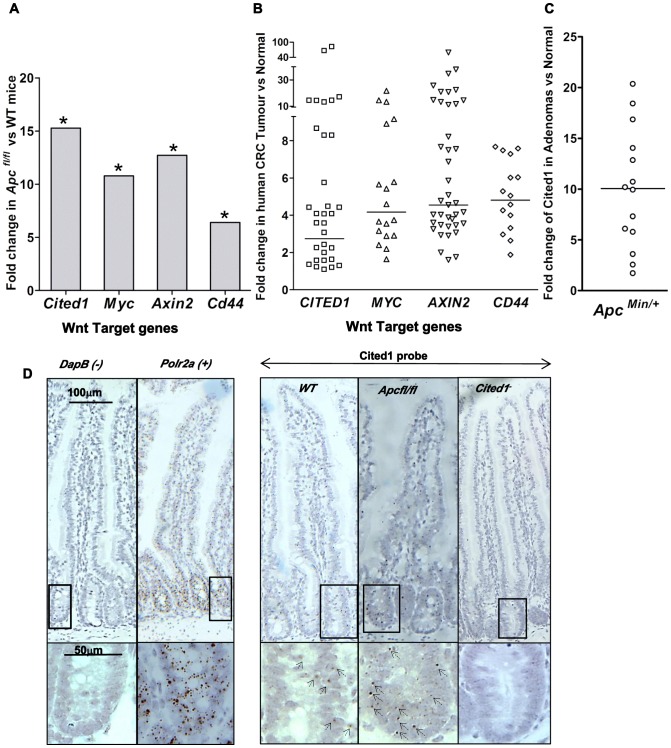

Cited1 over-expression in ApcMin/+ mice, AhCre+Apcfl/fl mice and human colorectal cancer.
A:
 QPCR analysis of Wnt target genes 4 days after conditional deletion of Apc in the small intestinal. * p<0.05, Mann-Whitney U test, n = 3. B: Taqman qPCR analysis of gene expression in human CRC tumour tissue presented as fold change relative to adjacent normal tissue. The horizontal line indicates median fold change. p<0.01, Wilcoxon Signed Rank Test. C: Semi-QPCR analysis of Cited1 expression in ApcMin/+ adenomas. Three ApcMin/+ mice were used and 3–6 tumours were taken from each individual, n = 14. (p<0.01, Mann-Whitney U test). D:
Cited1 in situ hybridization showing the increase in Cited1 expression in the AhCre+Apcfl/fl compare to AhCre+WT mouse. The staining is represented by single dots which correspond to the Cited1 transcript. The low level of staining (compared to positive control probe Polr2a) of Cited1 probe is distributed throughout the crypt-villus structure in the AhCre+WT mouse and in AhCre+Apcfl/fl mouse with an increase in staining after loss of Apc. Absence of staining is observed in the Cited1− intestinal tissue and in the negative control probe DapB. Inset panels show magnifications of intestine of corresponding zone.